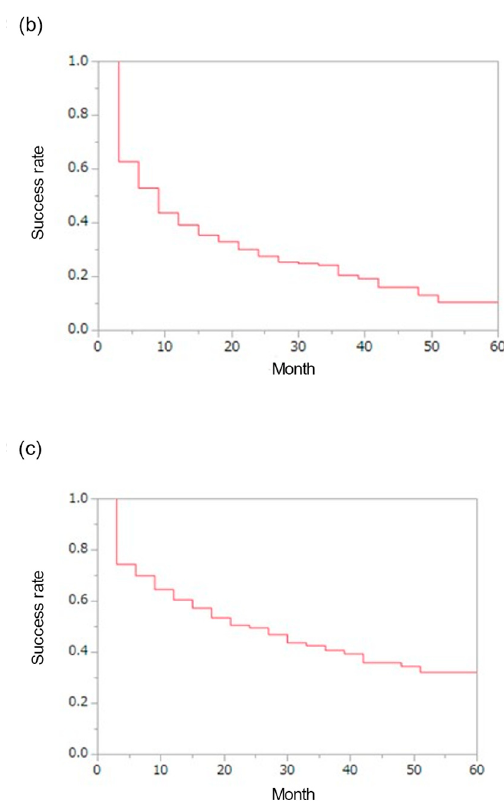
Figure 4. Comparison of survival curves by success definitions. ( a ) Complete success; ( b ) qualified success 1; ( c ) qualified success 2; Kaplan—Meier analysis.